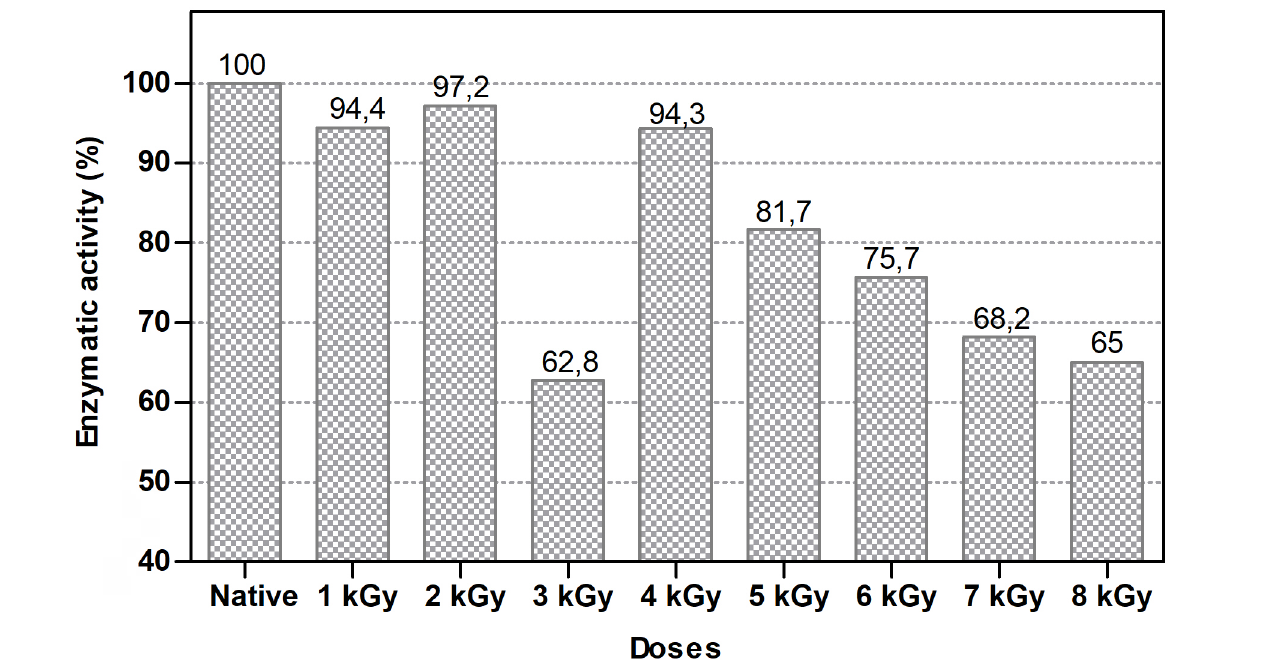
Figure 7. Enzymatic activity of nTeNT and iTeNT by FRET: Abz-GASQ↓FETSA-Q-EDDnp. Abz is bound to the N-amino terminal of synaptobrevin (aminoacids residues 73-81) and EDDnp to the C-terminal carboxyl group. Arrow (↓) indicates the bond